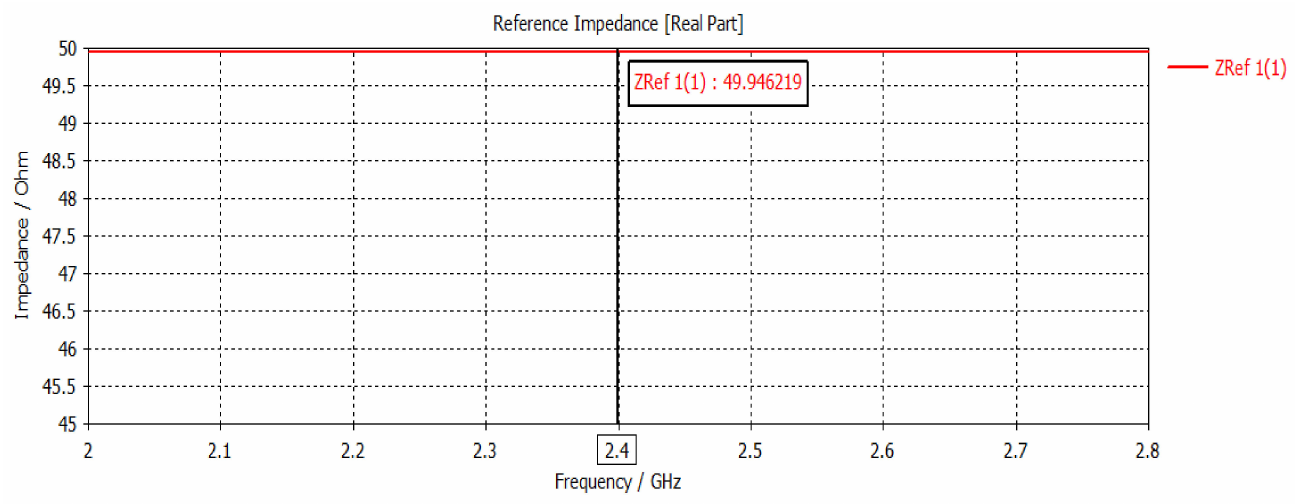
Figure 12. Impedance by frequency in patch antenna of 2.4 GHz with line transmission λ /4.